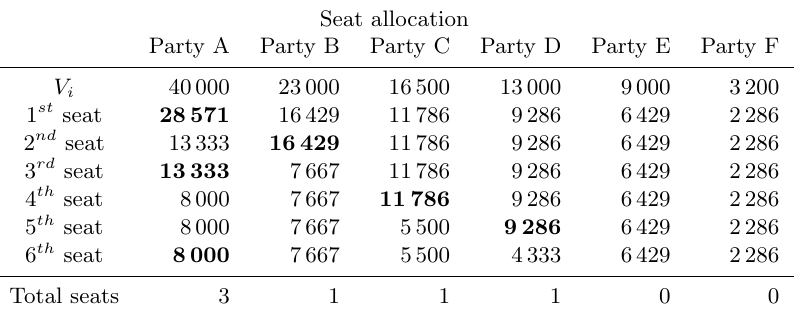
Table 3: An example of the seat allocation by means of the modified Sainte-Lagu¨e